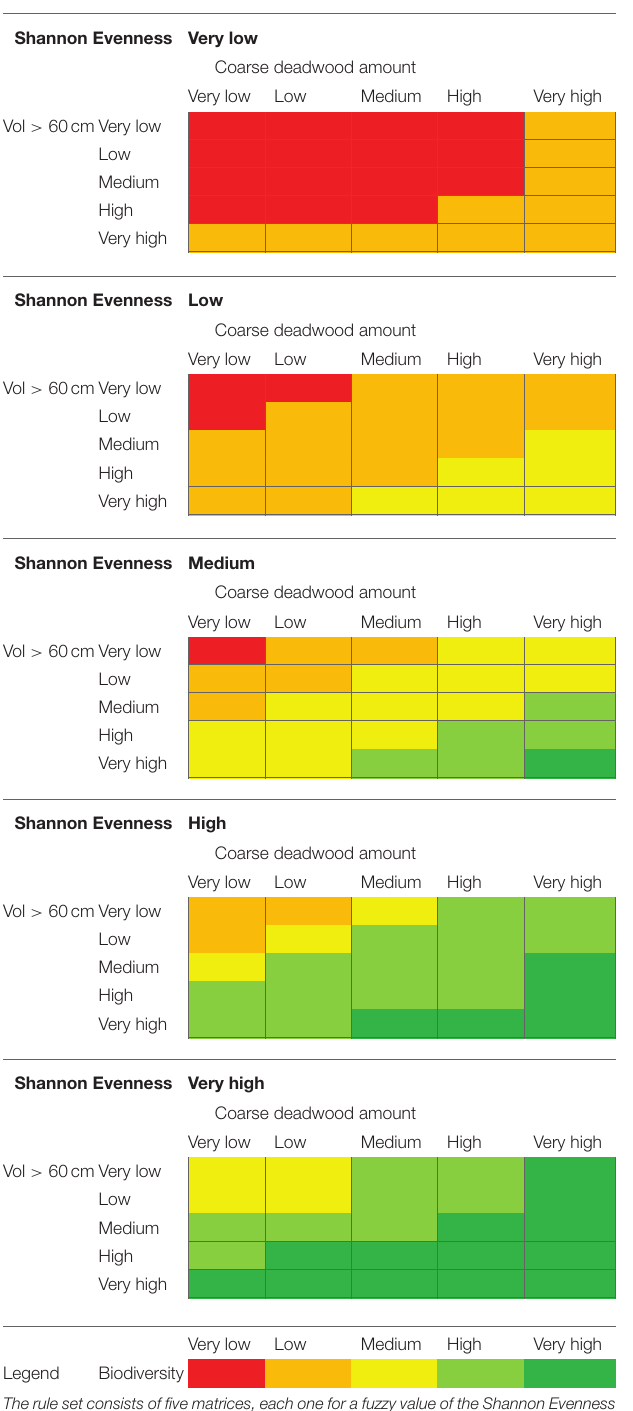
TABLE 4 | Fuzzy rule set for the assessment of sustainable wood production (according to Biber et al.,